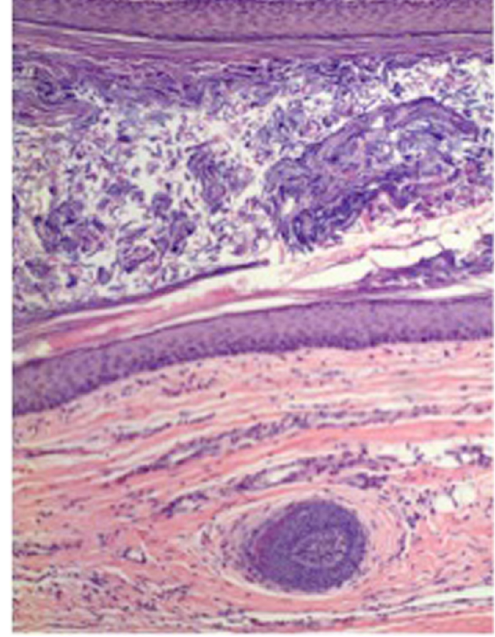
Figure 3 - Histopathological examination showing a dermoid cyst with a deep collagen layer and well formed stratified squamous epithelium. Hair follicles and sebaceous glands can also be seen (H & E, original magnification x200).